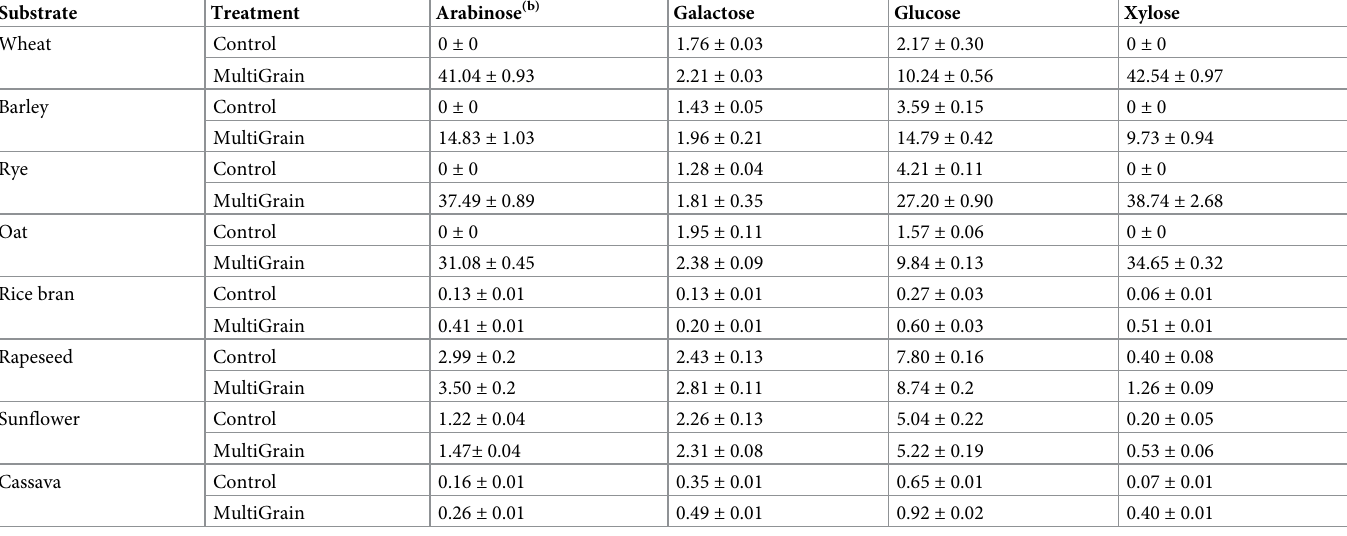
Table 3. Arabinose, galactose, glucose and xylose measured in the acid hydrolyzed supernatant of solution of different substrates incubated with a buffer solution (control) and MultiGrain for 2 hours at 40˚C (a) .